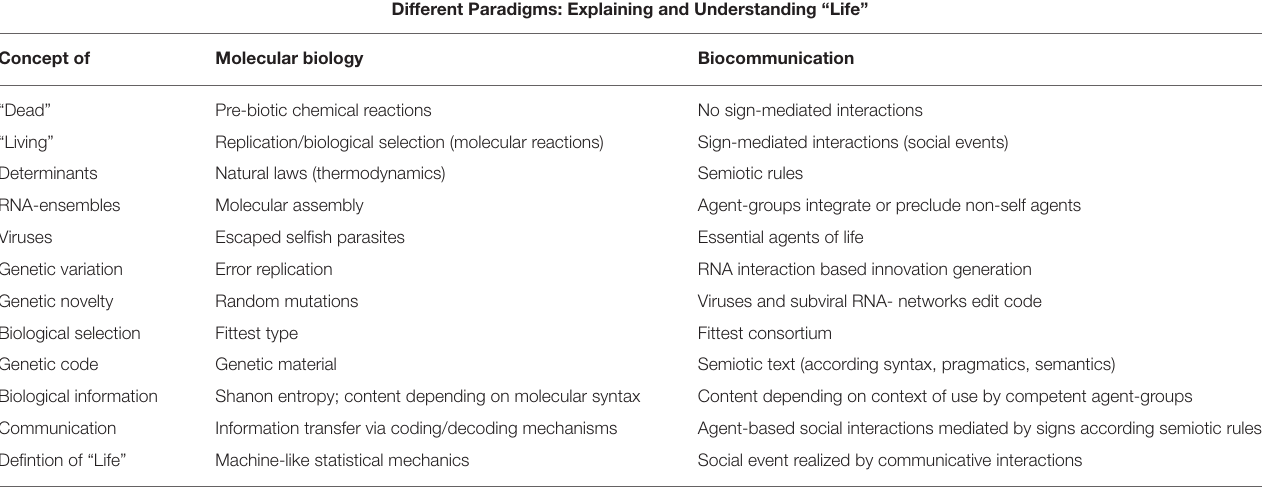
TABLE 1 | Different paradigms investigating living agents and defining life: the molecular biological paradigm explains all life processes primarily by the physical–chemical properties and statistical mechanics. Different Paradigms: Explaining and Understanding